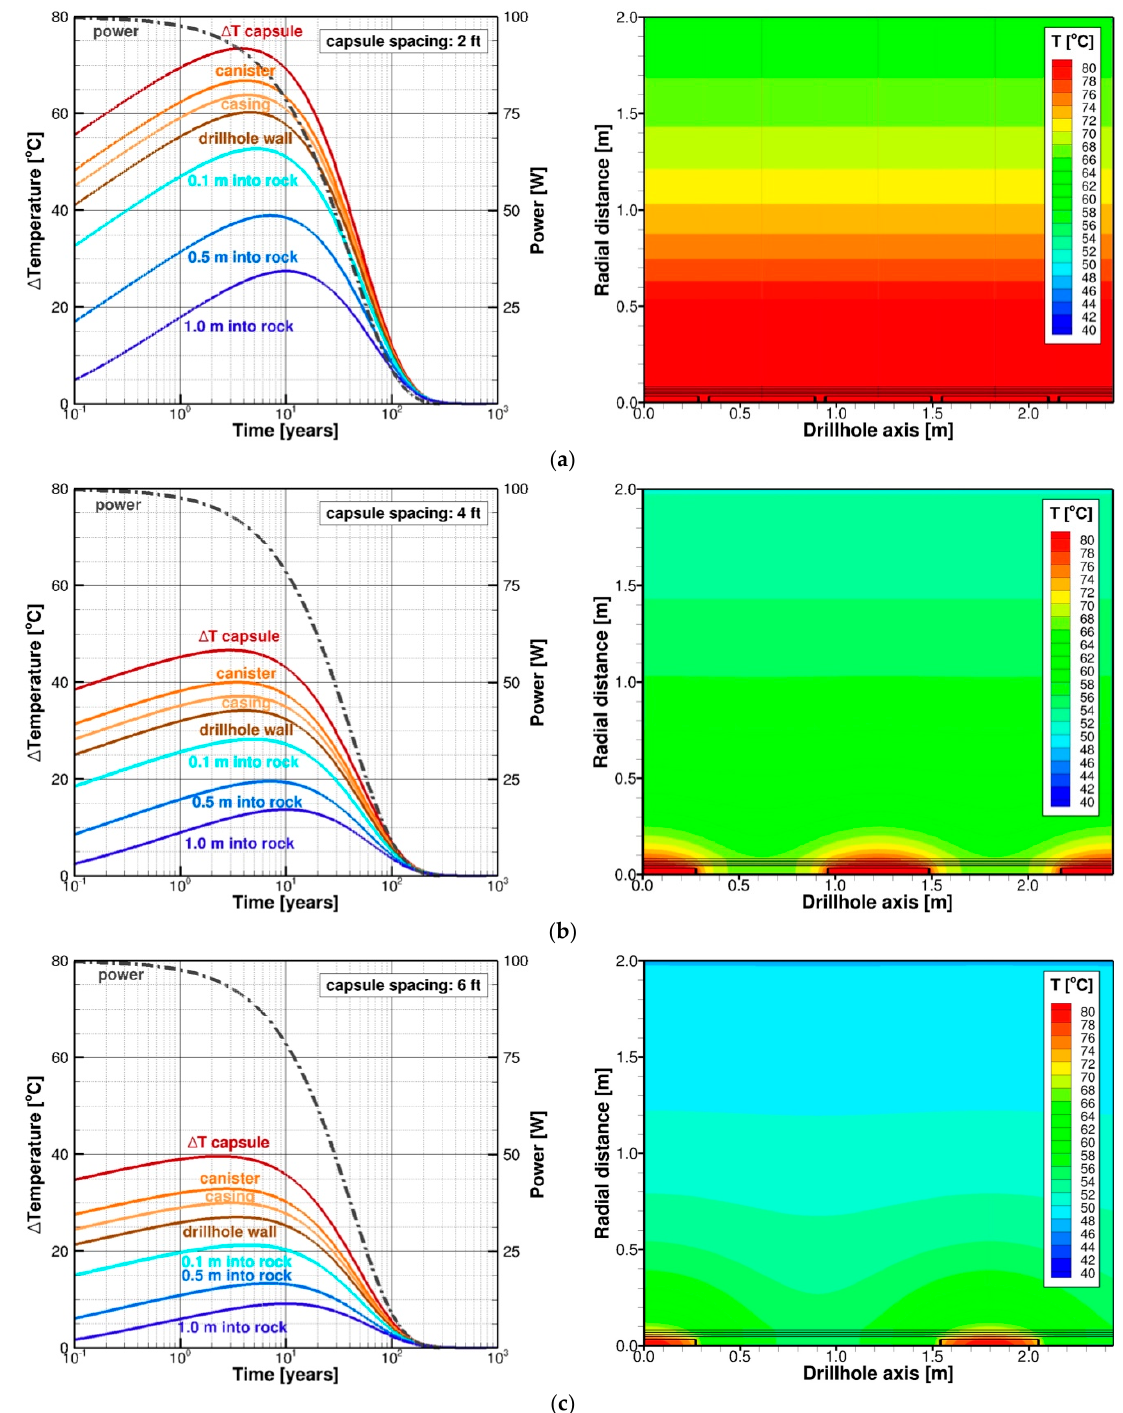
Figure 3. Evolution of temperature change and decay-heat output (left column) and temperature distribution after 3 years (right column) for an initial heat release of 100 W per waste capsule with capsule spacings of ( a ) 2 ft (0.6096 m); ( b ) 4 ft (1.219 m); and ( c ) 6 ft (1.829 m).